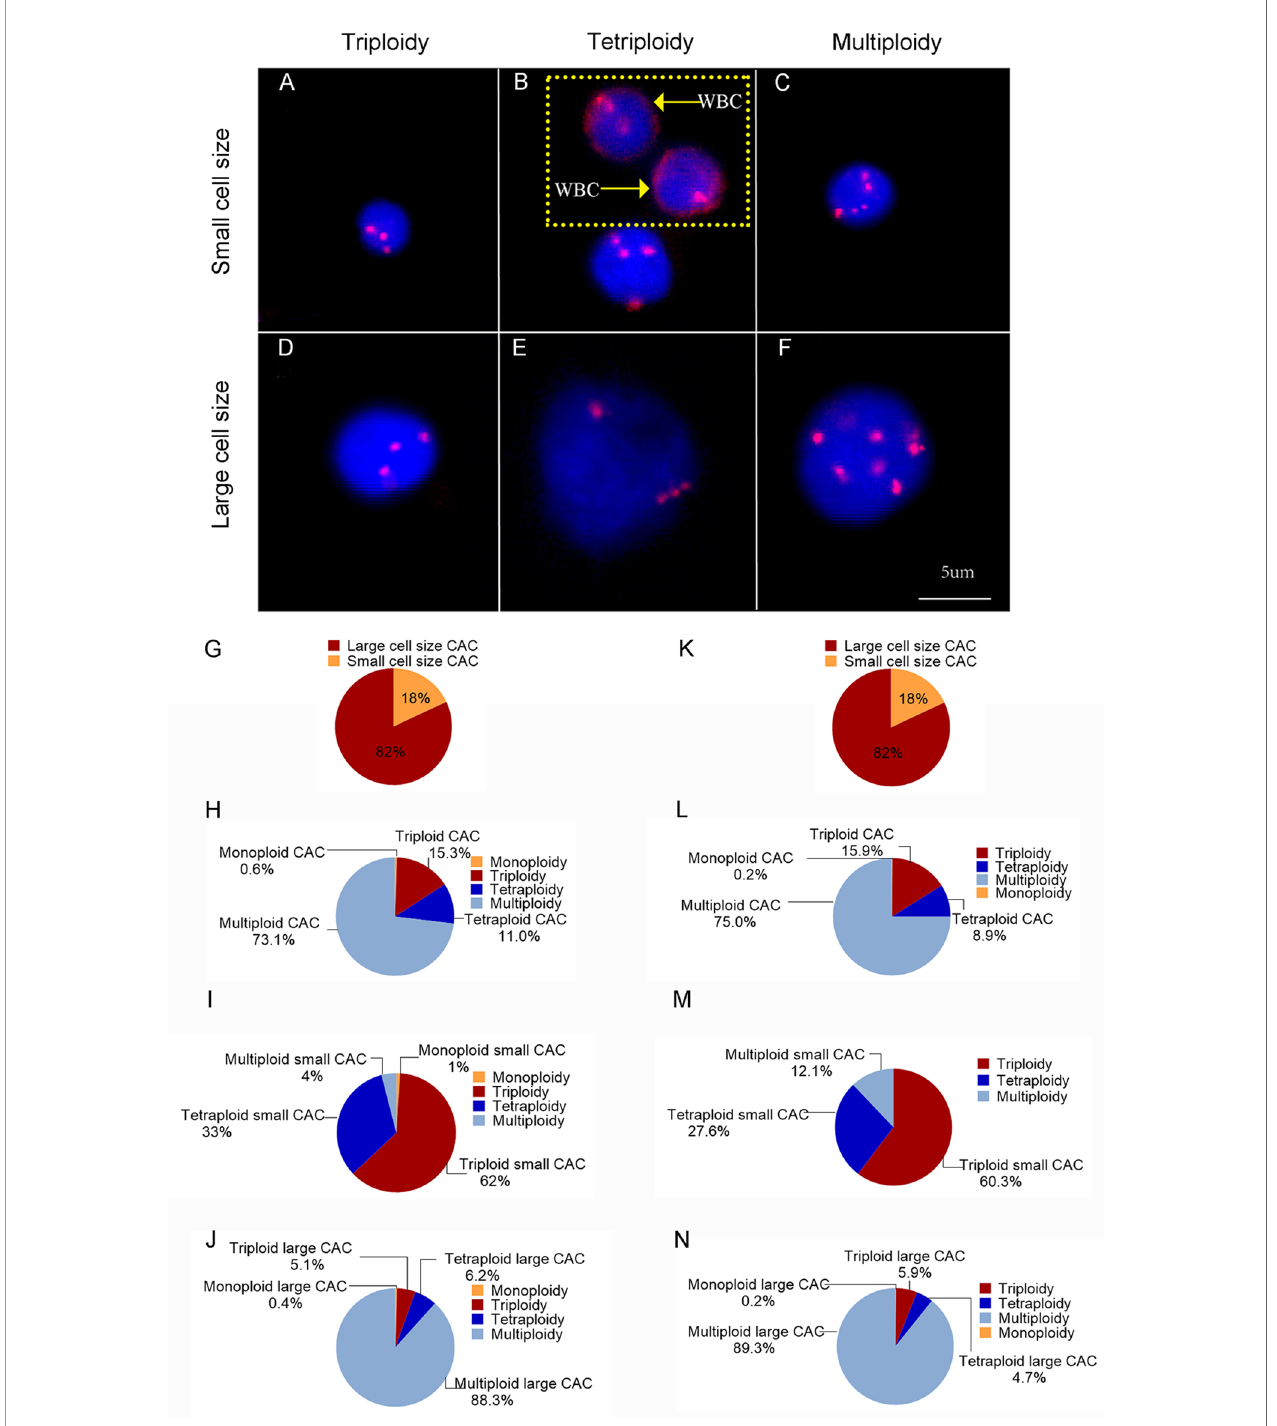
FIGURE 1 | CAC detection (A – F) Representative images of circulating aneuploid cells (CACs). (A – C) Small cell size CAC. (A) Triploid small cell size CAC. (B) Tetraploid small cell size CAC. The WBC (CD45 + ) is indicated by a yellow arrow. (C) Multiploid small cell size CAC. (D – F) Large cell size CAC. (D) Triploid large cell size CAC. (E) Tetraploid large cell size CAC. (F) Multiploid large cell size CAC. (G – J) Pre-surgery CAC subtype distribution in 50 patients. (G) Proportion of small cell size and large cell size CACs. (H) Proportion of heteroploid subtypes of total CACs. (I) Proportion of heteroploid subtypes of small cell size CACs. (J) Proportion of heteroploid subtypes of large cell size CACs. (K – N) Post-surgery CAC subtype distribution in 35 patients. (K) Proportion of small cell size and large cell size CACs. (L) Proportion of heteroploid subtypes of total CACs. (M) Proportion of heteroploid subtypes of small cell size CACs. (N) Proportion of heteroploid subtypes of large cell size